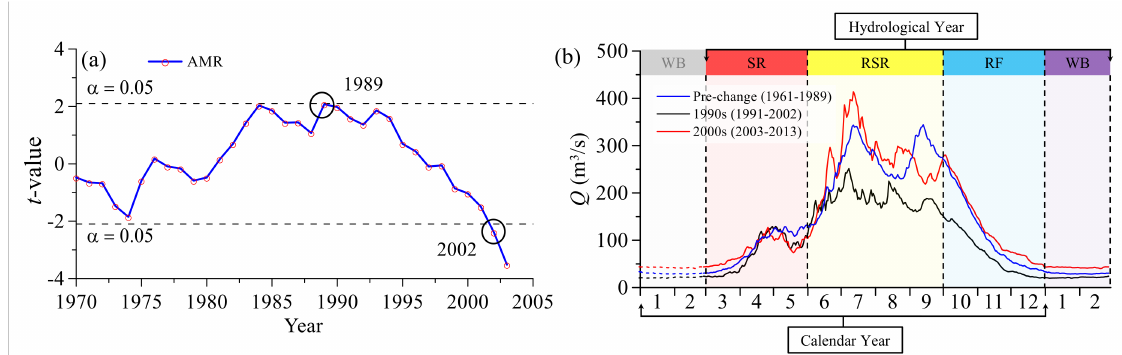
Figure 3. ( a ) The change points of annual mean runo ff detected by moving t -test ( b ) comparison of daily runo ff regime of the three periods and the definition of hydrological year.